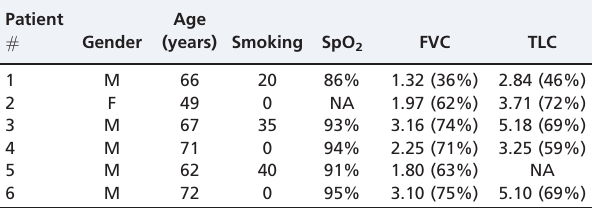
Table 1 - Demographics and pulmonary function of the study’s patients.